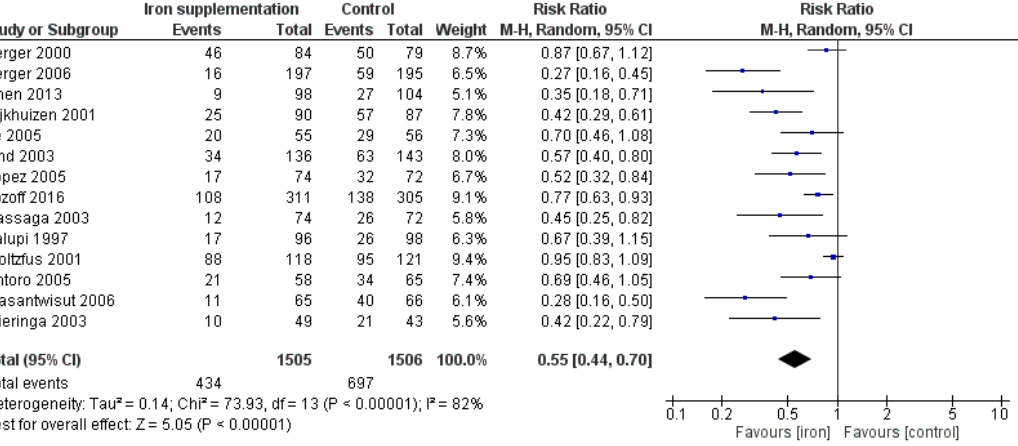
Figure 2. Iron supplementation versus placebo/no intervention (efficacy studies) on the risk of anemia (hemoglobin concentration < 110 g/L).